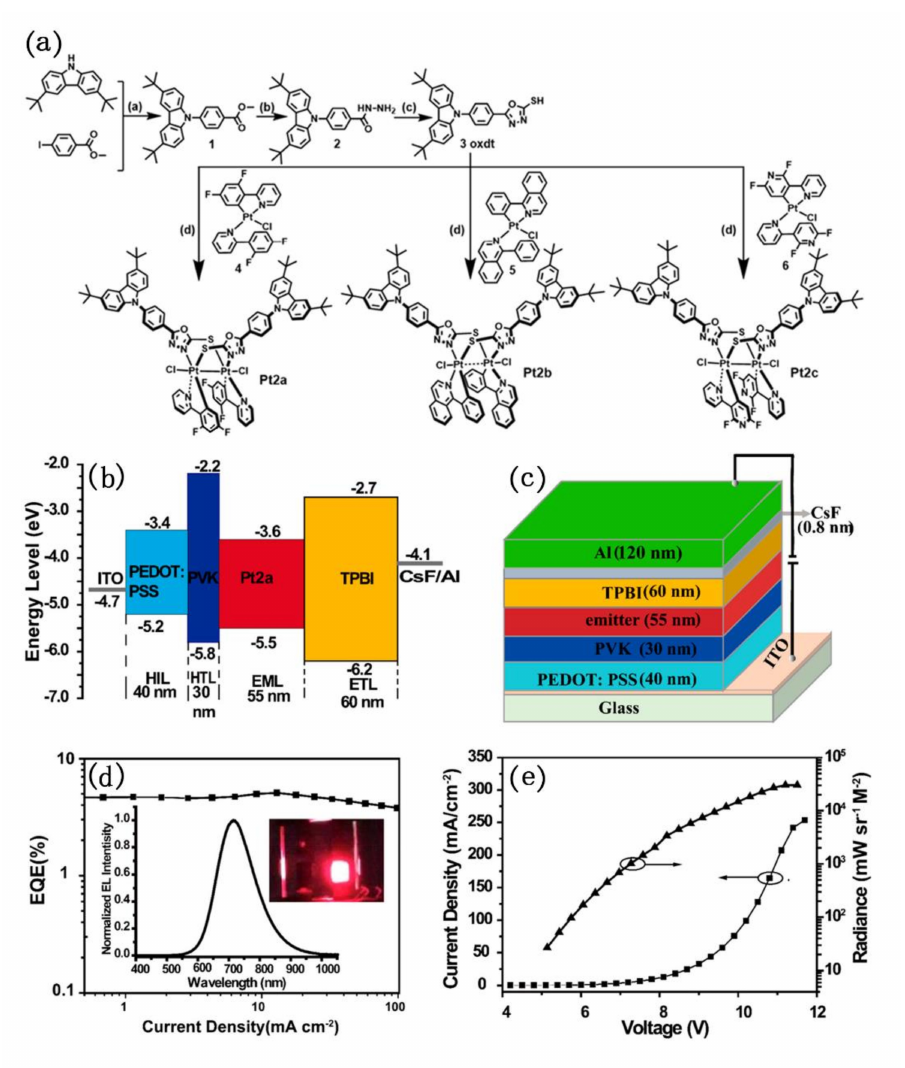
Figure 16. ( a ) The synthetic route of Pt2a – Pt2c ; ( b ) energy-level diagrams, and ( c ) configuration of the device; ( d ) EQE curves of the device. Insets: EL spectra and a photograph of thebdevice in operation. ( e ) Current density − voltage − radiance (J − V − R) curve of the device. Reprinted with permission from [83]. Copyright 2020, American Chemical